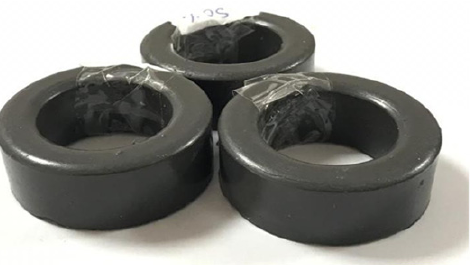
Figure 4. Toroidal magnetic cores elaborated with the composite material after machining.